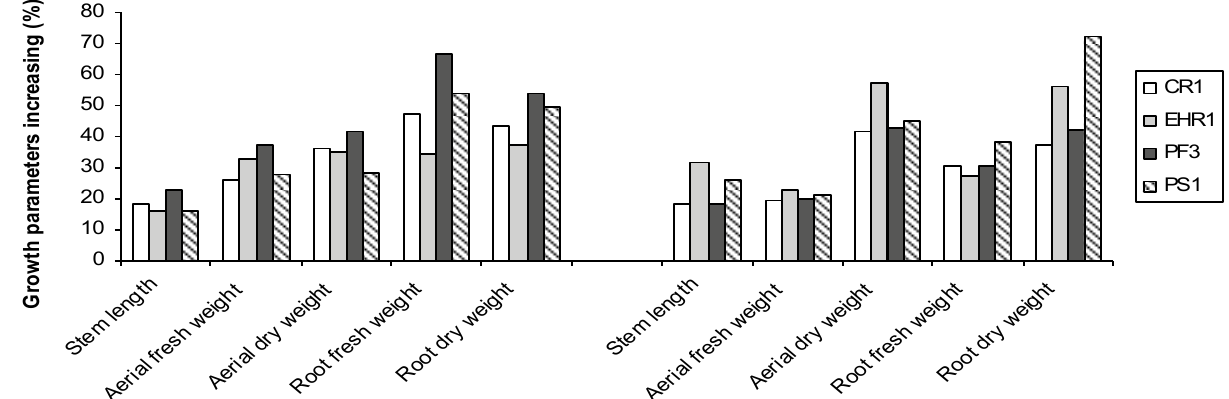
Figure 3. Mean Percentage increases of plant growth parameters for the most effective endophytic bacterial strains assessed in this study (left: in vitro ; right: in vivo ). CR1= Bacillus amyloliquefaciens ; EHR1= Bacillus cereus ; PF3= Bacillus methylotrophicus ; PS1= Pseudomonas